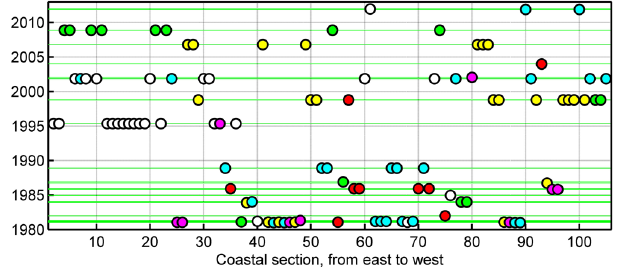
Fig. 8. Pattern of storms generating the highest waves approach- ing from the direction of ± 15 ◦ with respect to the normal to the coast. The horizontal lines indicate storms that produced the high- est almost-normal waves at least in one coastal section. Each storm is marked with a single colour. The colours vary cyclically. Fig. 9. Highest breaking waves (coloured lines) approaching from different ranges of directions with respect to the coast normal in the study area. The bold blue line shows the all-time highest waves approaching from any direction, and the bold red line shows the all- time highest almost-incident waves ( ± 10 ◦ with respect to the coast normal). The light red bars indicate the regions with gently sloping coast in which the maximum set-up likely exceeds 40cm.